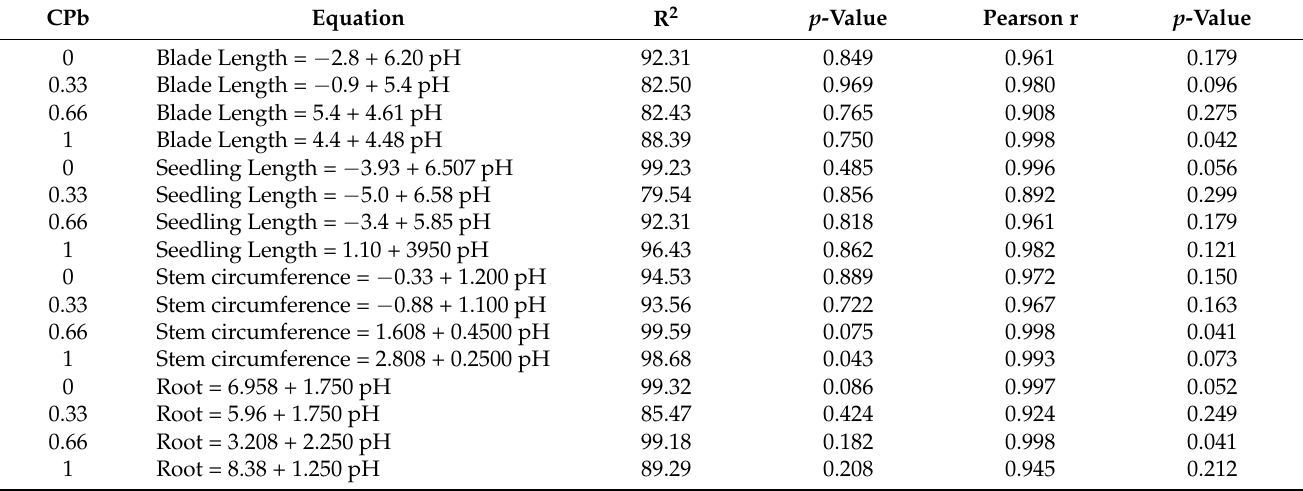
Table 6. Relationship of the maize leaf length, height of the entire plant, stem circumference, and length of the main root according to the pH of the water, at the four levels of CPb at 60